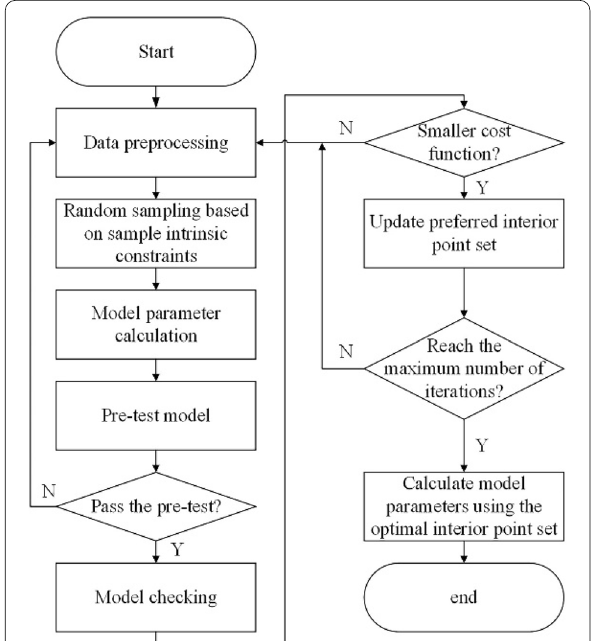
Figure 13 Flow chat of the improved RANSAC algorithm